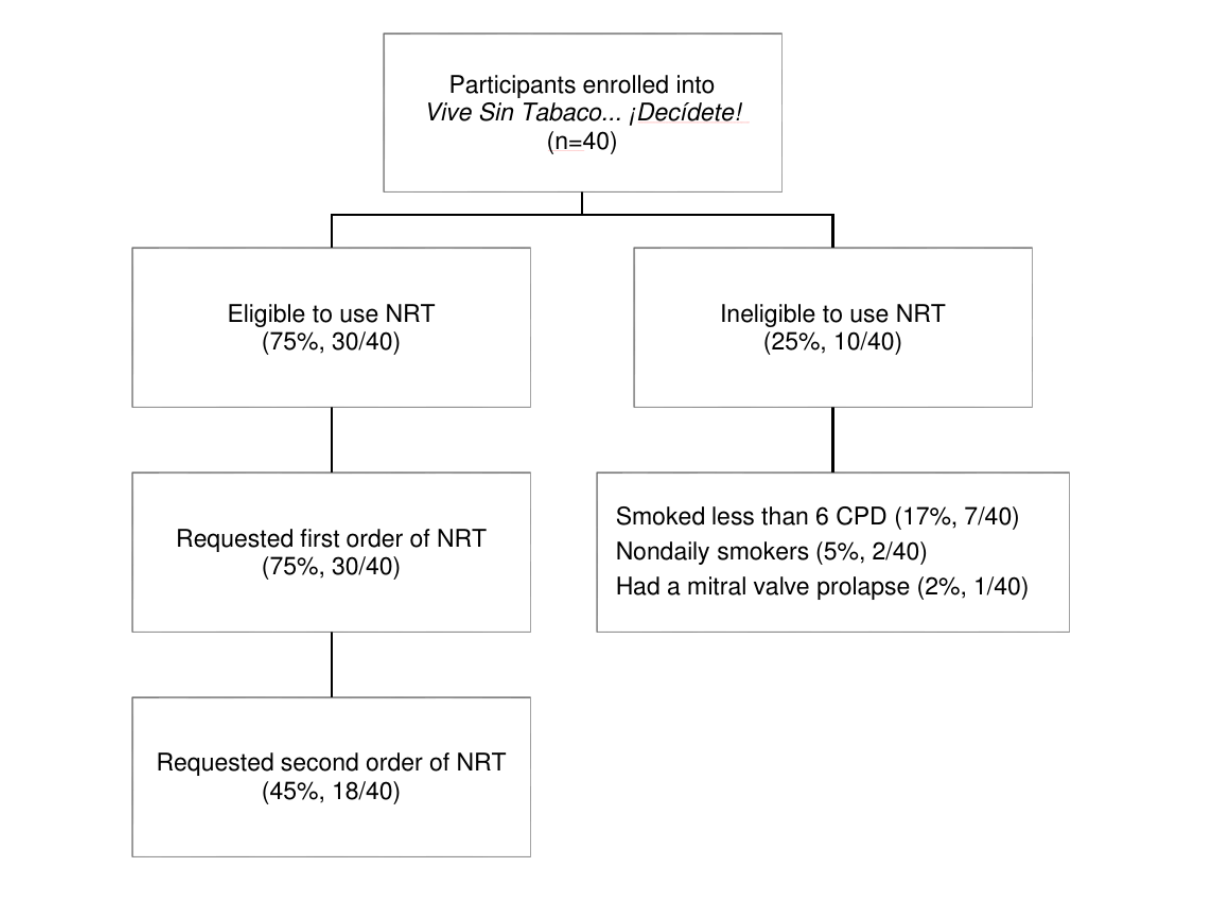
Figure 3. Utilization of nicotine replacement therapy (NRT) during the intervention. CPD: cigarettes per